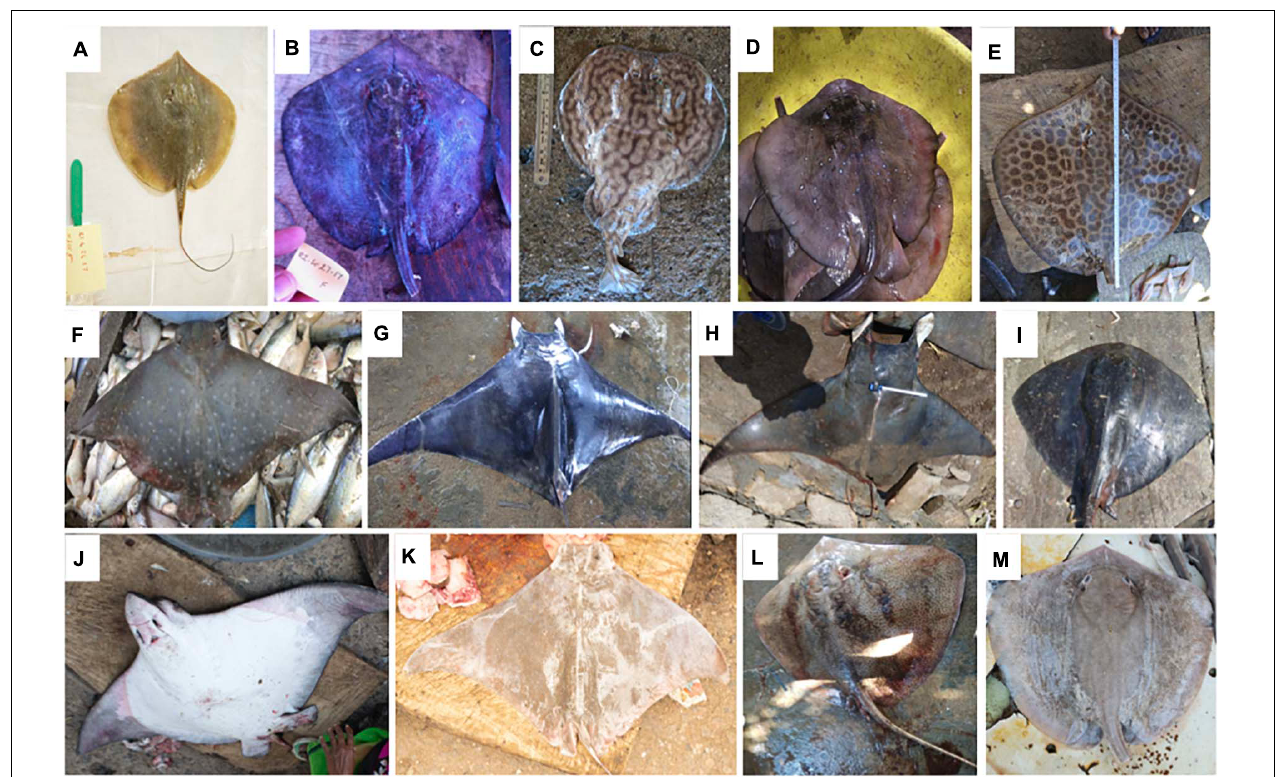
FIGURE 3 | Representative pictures of species sampled in the superorder Batoidea. (A) Brevitrygon walga (Arabian Dwarf Whipray), (B) Pateobatis bleekeri (Bleeker’s Whipray), (C) Torpedo sinuspersici (Variable Torpedo ray), (D) Maculabatis gerrardi (Whitespotted Whipray), (E) Himantura leoparda (Leopard Whipray), (F) Aetobatus ocellatus (Whitespotted Eagle ray), (G) Mobula mobular (Spinetail Devil ray), (H) Mobula tarapacana (Sicklefin Devil ray), (I) Pteroplatytrygon violacea (Pelagic Stingray), (J) Aetobatus flagellum (Longheaded Eagle ray), (K) Rhinoptera jayakari (Oman Cownose Ray), (L) Himantura uarnak (Reticulate Whipray), and (M) Maculabatis bineeshi (Short-tail Whipray).